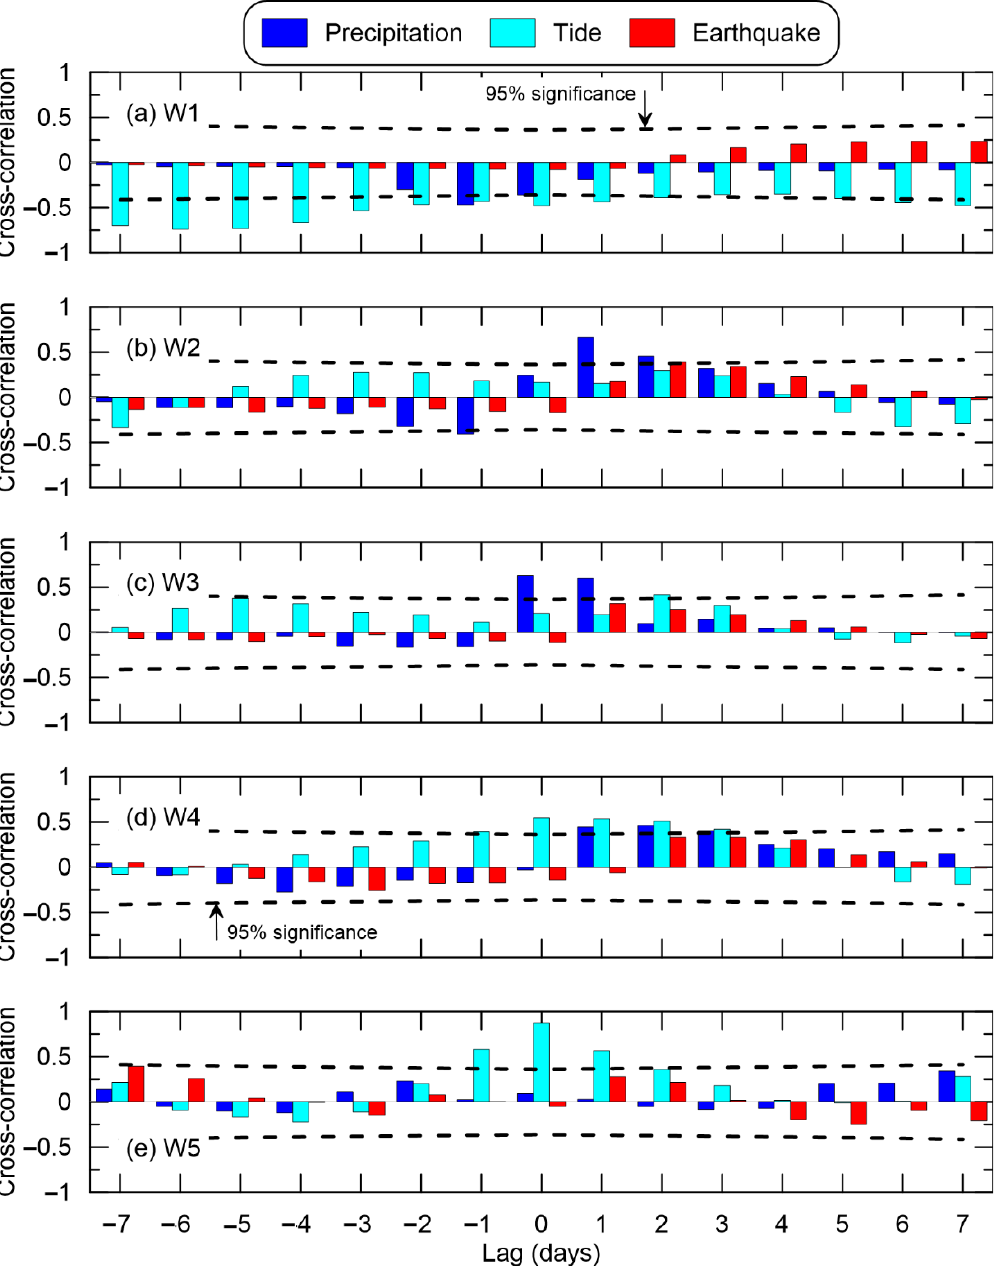
Figure 11. Cross-correlation analysis between groundwater levels in wells ( a ) W1, ( b ) W2, ( c ) W3, ( d ) W4, and ( e ) W5 against precipitation, tide, and earthquake, showing lag in days at 1 week before and after the main shock.